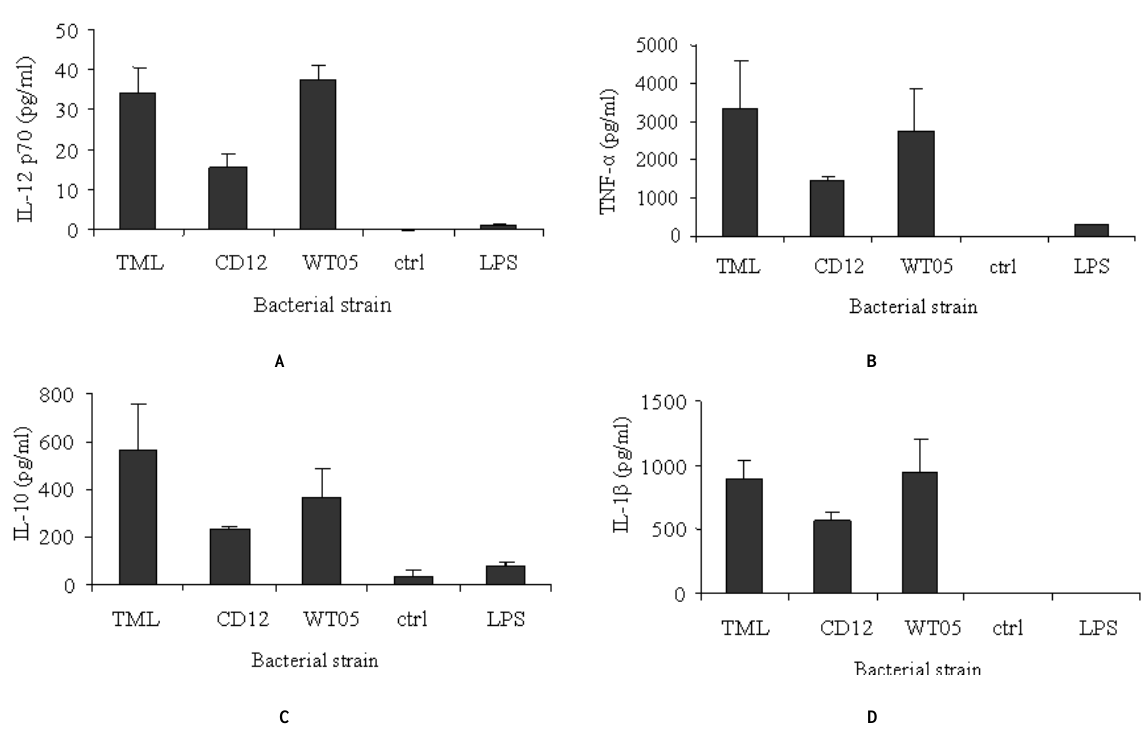
FIGURE 2 . Graphs representing secretion of cytokines following infection of DC with strains CD12, WT05, and TML, as well as control (uninfected) DC, and DC after exposure to S . typhimurium LPS. Secretion of IL-12 p70 is shown in (A), TNF-α (B), IL-10 (C), and IL-1β (D). The MOI was 1:1 and the number of cells infected was 2  10 5 . The difference between strains CD12 and WT05 was statistically significant for IL-12 release- p value 0.05 (as calculated by student T test); there was no statistical difference for TNF-α ( p 0.46), IL-10 ( p 0.46), IL-1β ( p